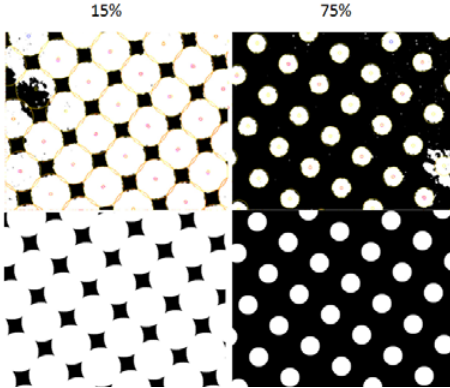
Figure 19. Noise part before and after sensor